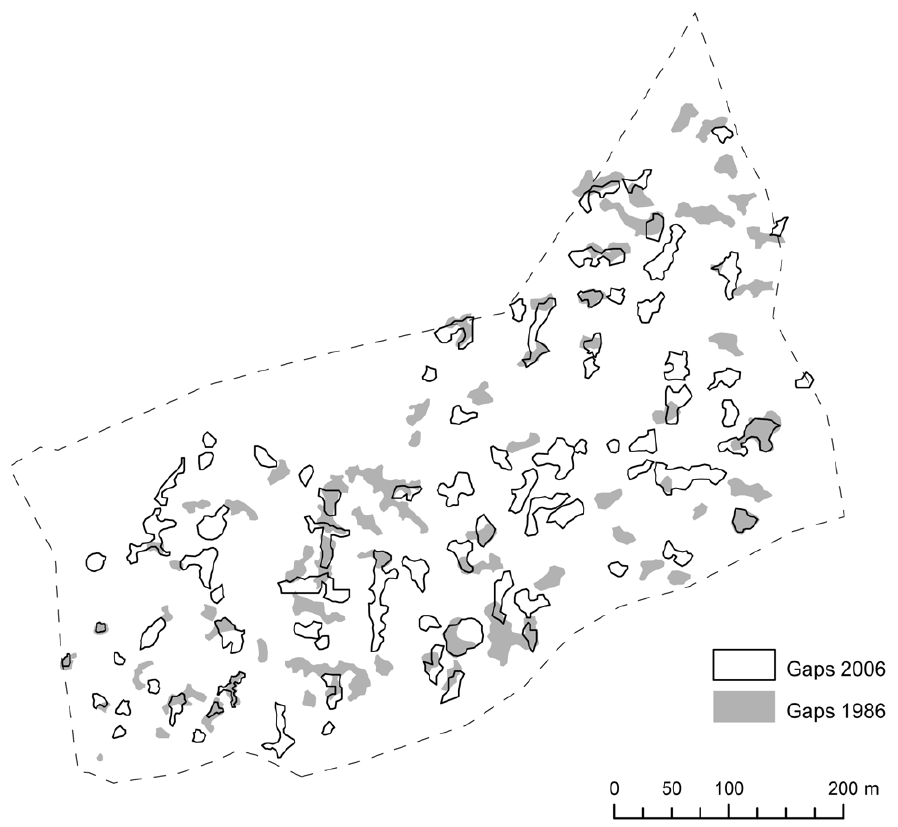
Figure 2. Gap dynamics in the Gorjanci forest reserve in the studied period (1986–2006).